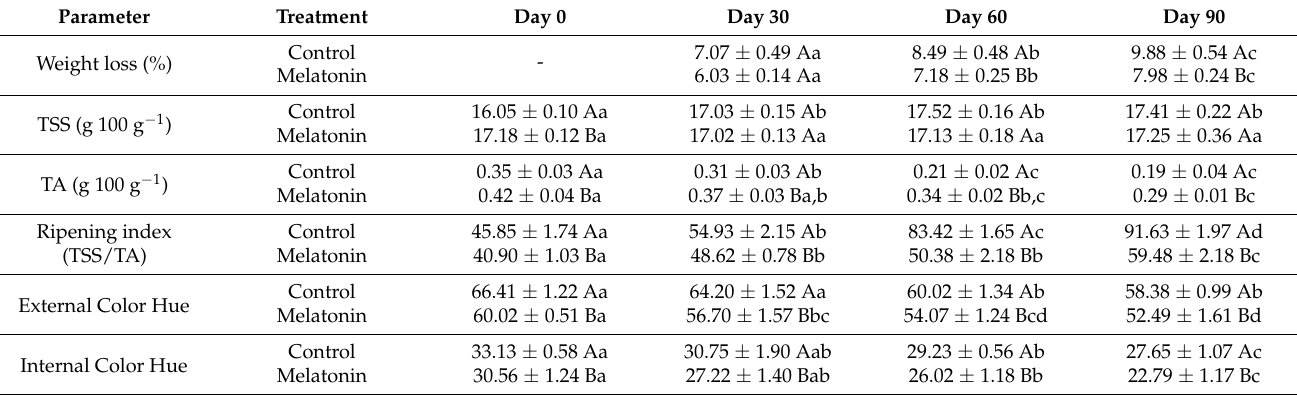
Data are the mean ± SE. For each parameter, different lowercase letters within a row show significant differences at p < 0.05 during storage, while capital letters show significant differences at p < 0.05 between treatments for each sampling